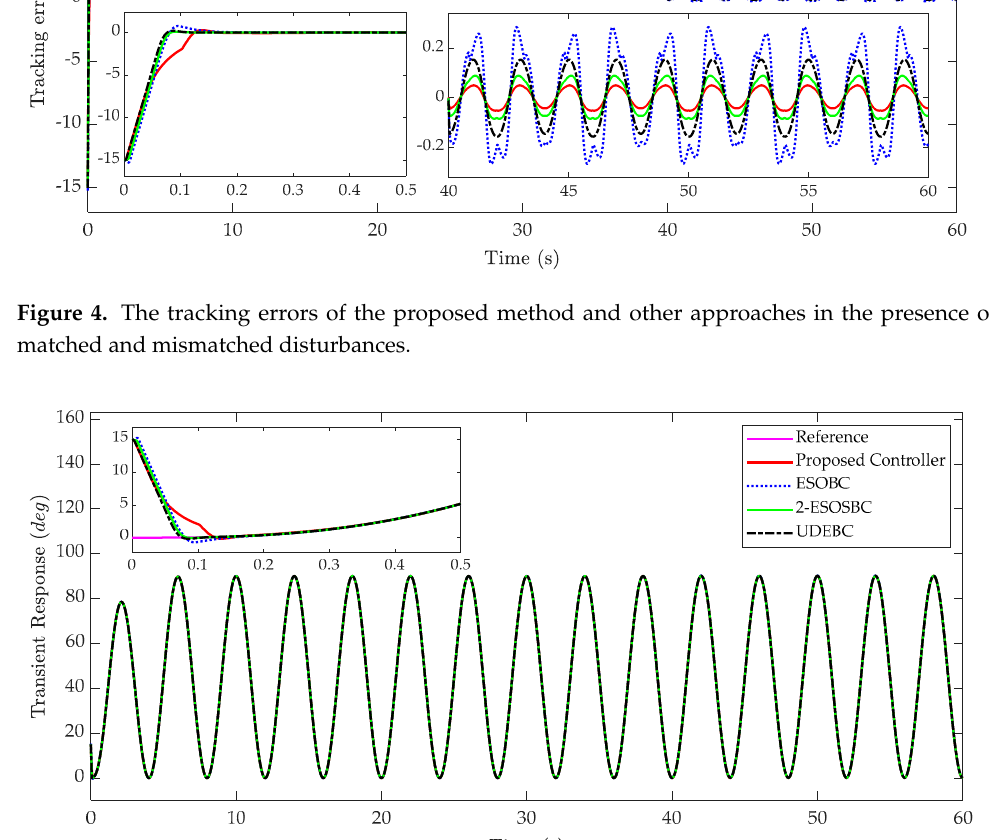
Figure 5. The tracking performance of the proposed method compared with those of other ap- proaches. Table 2. The maximal absolute values of tracking error in the steady-state phase.